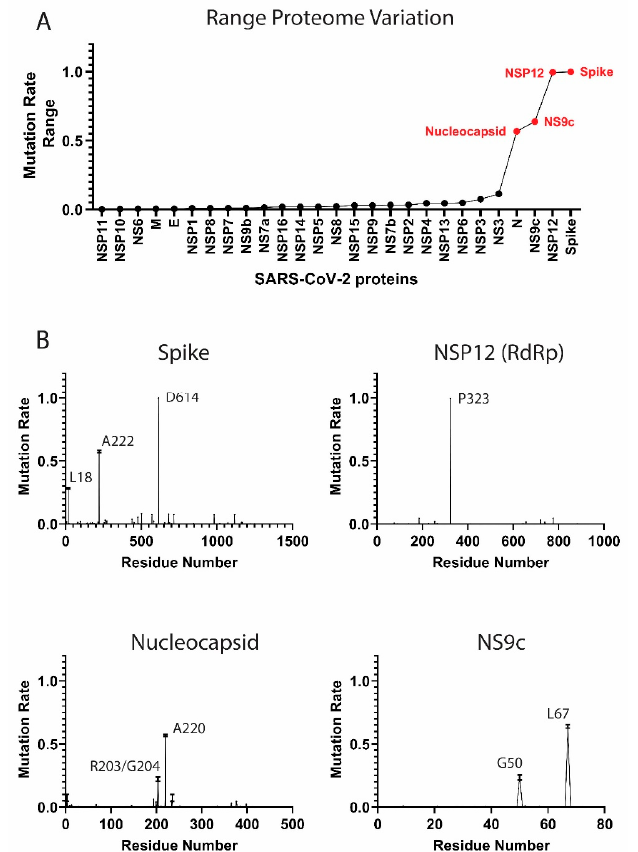
Figure 1. Mutation rates in the severe acute respiratory syndrome coronavirus 2 (SARS-CoV-2) proteome. ( A ) Proteome-wide analysis of the observed mutation rate range for 27 SARS-CoV-2 proteins. Range for each protein is calculated as the difference between the highest residue MR and lowest MR. Red labels correspond to proteins with a range > 0.50. ( B ) Select examples of high- frequency mutating SARS-CoV-2 proteins (main mutation rates in residues D614 (S), A222 (S), L18 (S), P323 (NSP12), R203 (N), G204 (N), A220 (N), G50 (NS9c), and L67 (NS9c). Standard deviation